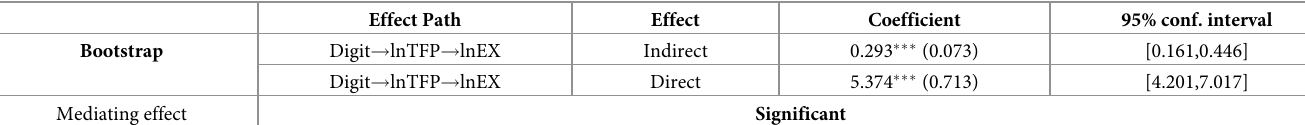
Table 6. Results of mediation test.